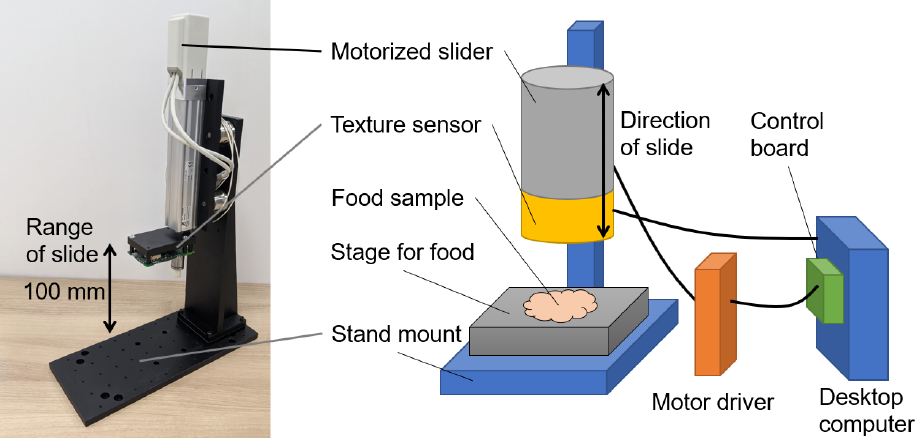
Figure 4. Measurement system for the texture